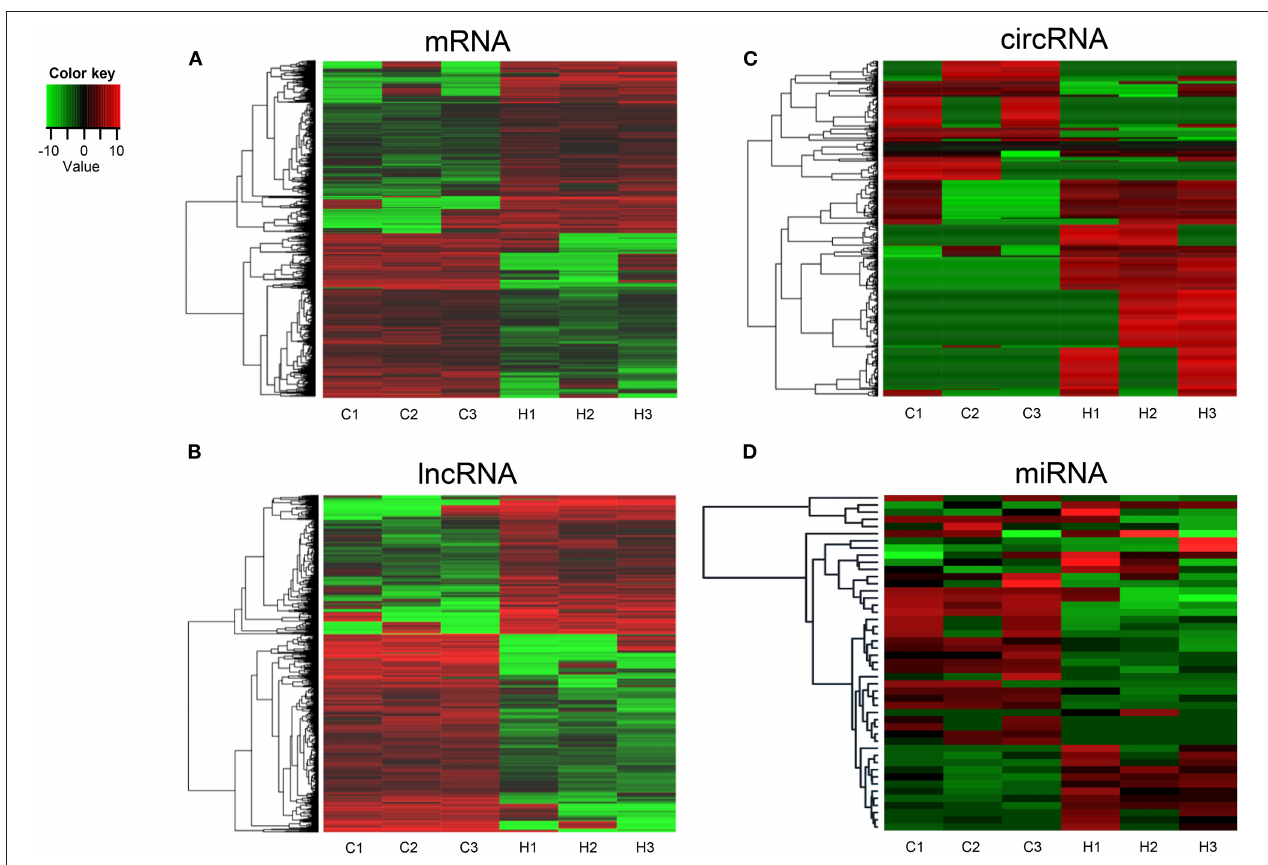
FIGURE 2 | Hierarchical clustering of mRNA (A) , lncRNA (B) , circRNA (C) , and miRNA (D) in HT group and non-HT group. C1-C3: non-HT group; H1-H3: HT group. The red and the green shades indicate the expression above and below the relative expression, respectively, across all samples.